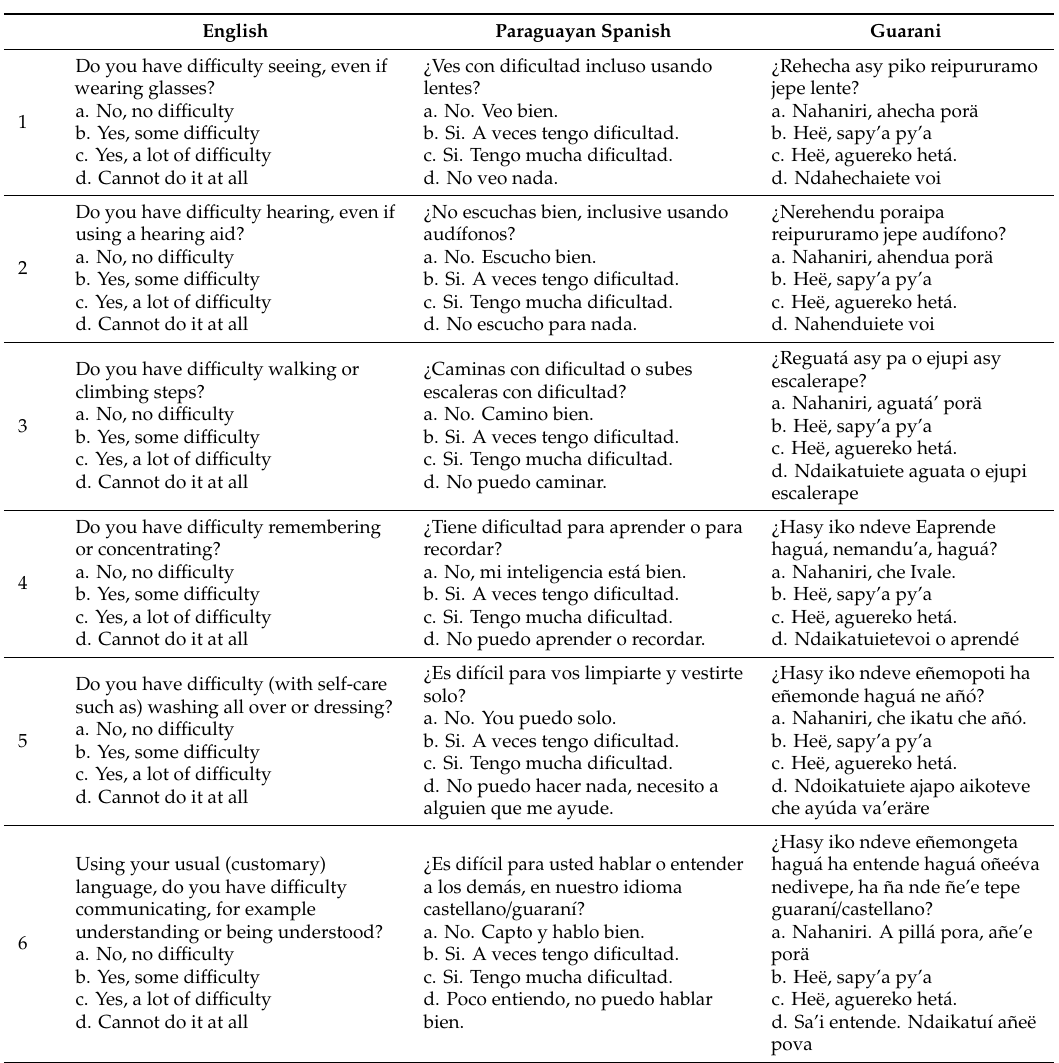
Table 1. Translated Washington Group short set (WG-SS) questions and answers into Paraguayan Spanish and Guarani.